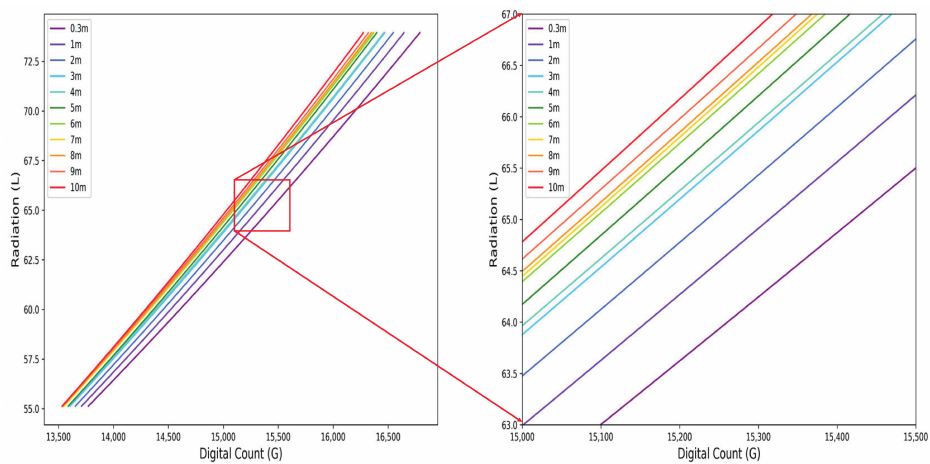
Figure 10. Radiation-Digital count mapping curve that changes with distance through actually obtained data.